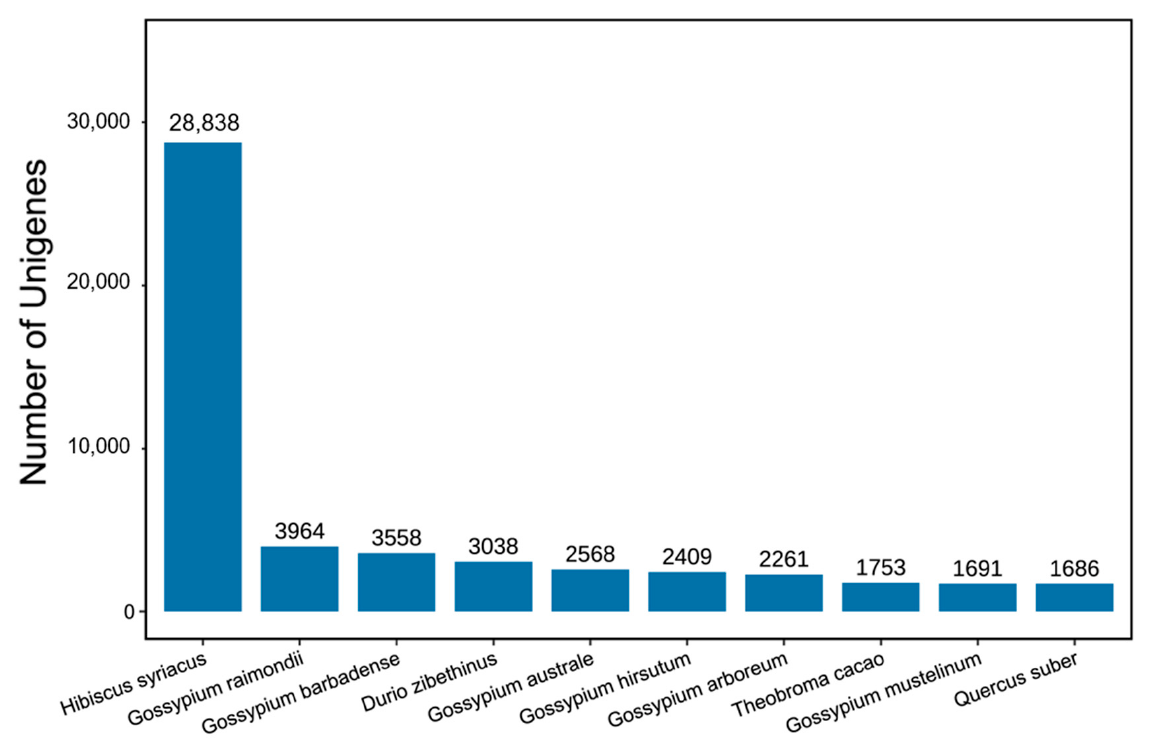
Figure 4. Alignment of homologous sequences from different species. The “X” axis shows different species, and the “Y” axis indicates the number of similar unigenes.